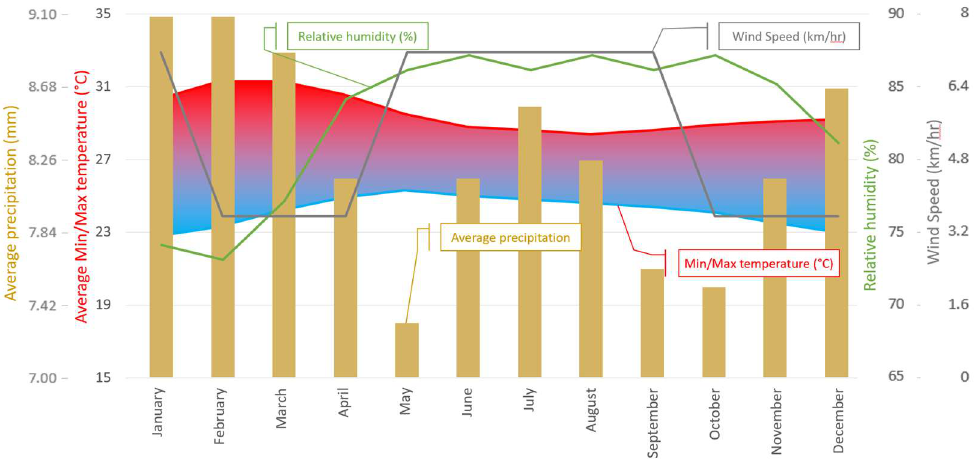
Figure 5. Monthly average precipitation (mm), relative humidity (%), wind speed (km/hr), and max- imum/minimum temperature (°C) for Sri Lanka. maximum/minimum temperature ( ◦ C) for Sri